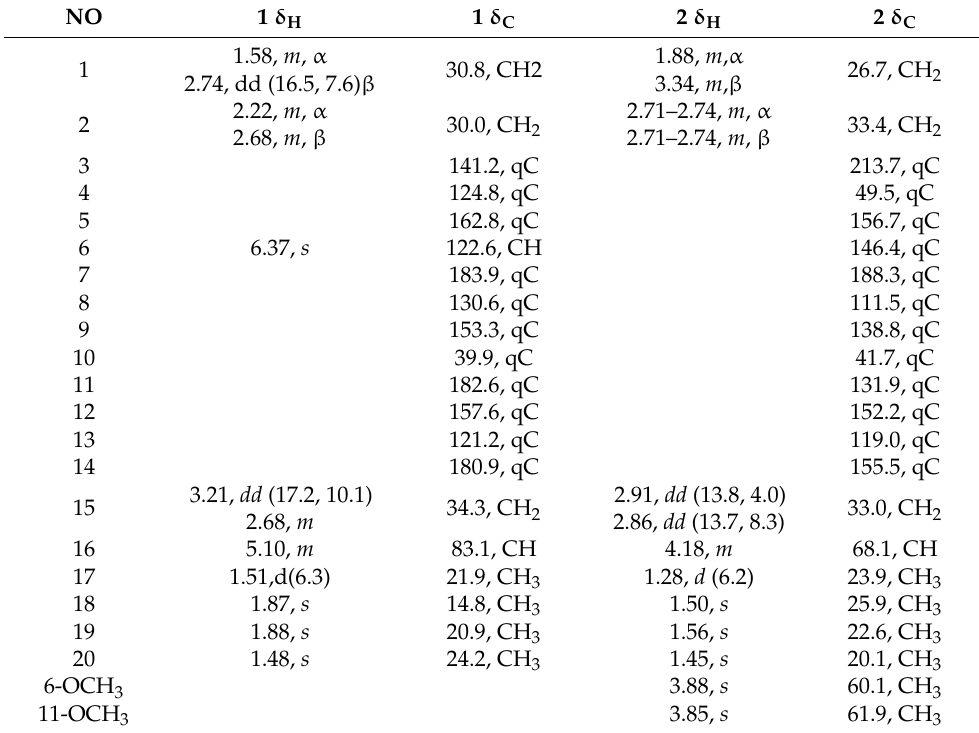
Table 1. NMR spectroscopic data for compounds 1 and 2 in CDCl 3 ( δ in ppm, J in Hz). NO 1 δ H 1 δ C 2 δ